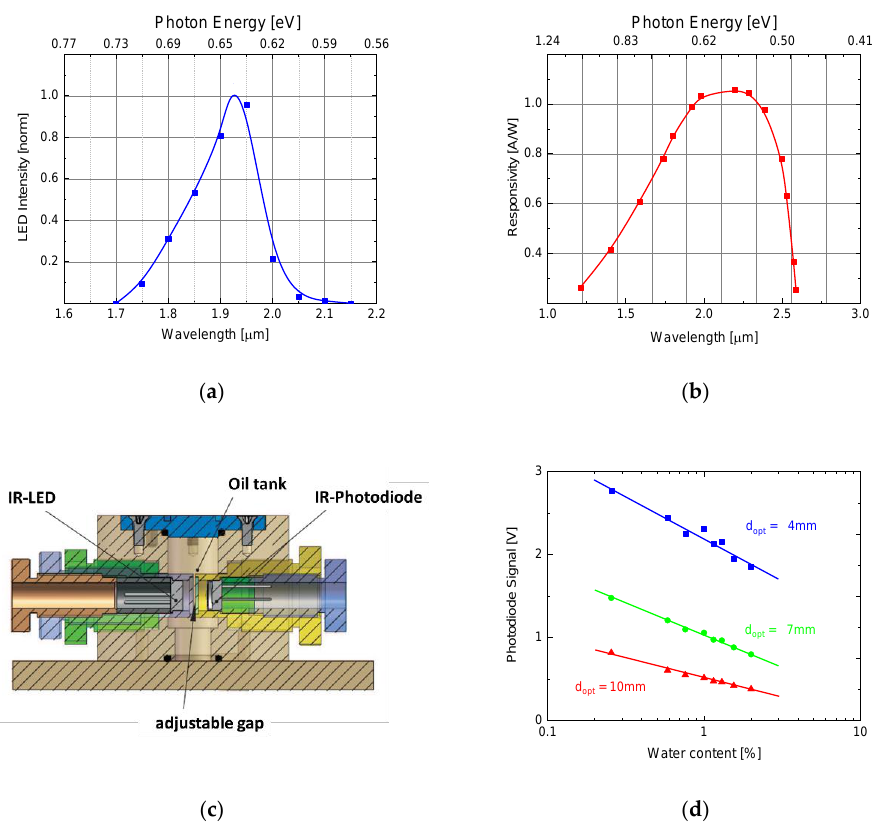
Figure 9. ( a ) Emission spectrum of commercial NIR-LED (IR S-LED 1,94; Roithner) [6]. ( b ) Spectral sensitivity of commercial NIR photodiode (InGaAs) (FGA 20 Thorlabs) [6]. ( c ) Cuvette for sensor investigation tests featuring screw-in MEMS emitter and receiver elements allowing for experiments with variable optical gap lengths [6]. ( d ) Variation of IR transmission of Skydrol LD4 with increasing water content as measured with the test set-up of Figure 9c and the optical components of ( a , b ) at a wavelength of λ = 1.94 µm and at different absorption path lengths [6].